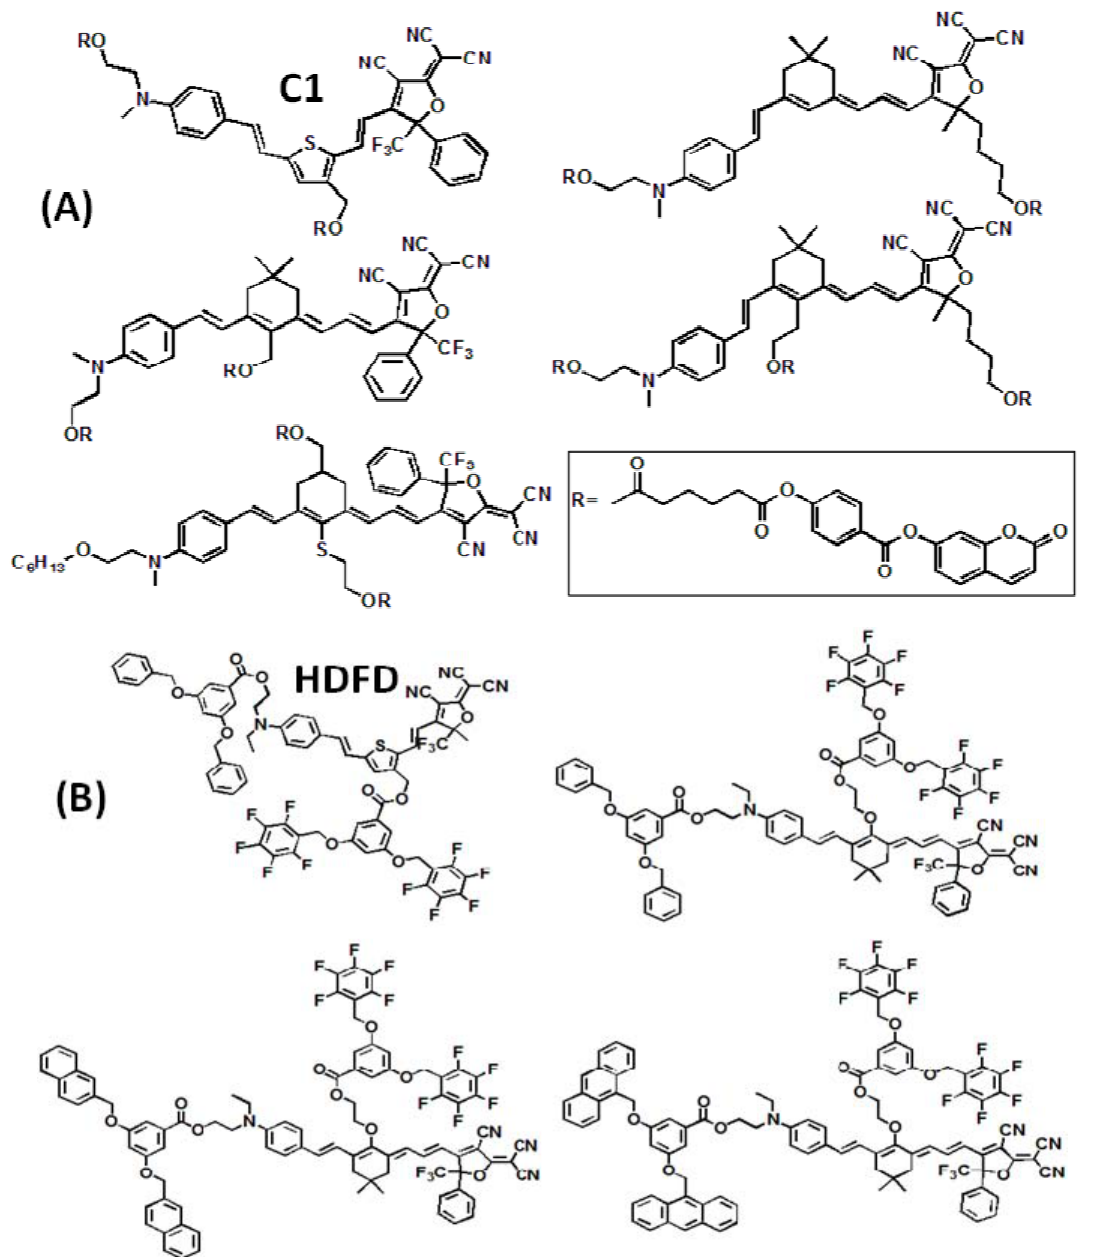
Figure 6. Dendritic structures based on exploiting dendron (or pendant) intermolecular interactions are shown. The prototypical coumarin dendrimer ( A ) and arene-perfluoroarene dendrimer ( B ) structures are denoted C1 and HDFD